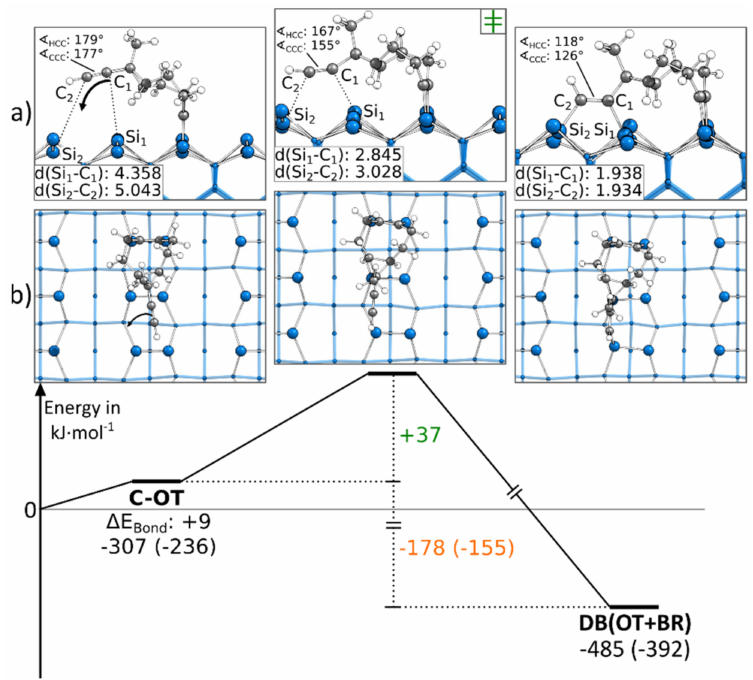
Figure 3. Reaction from a C-OT to a DB(OT+BR) structure, with side ( a ) and top ( b ) views of the minima and transition states. Electronic (Gibbs) bonding energies are stated for the minima. Activation energies ( ∆ E Act ) are shown in green, and electronic (Gibbs) reaction energies ( ∆ E React ) are shown in orange. All values are expressed in kJ · mol − 1 , and Si-C bond lengths are expressed in